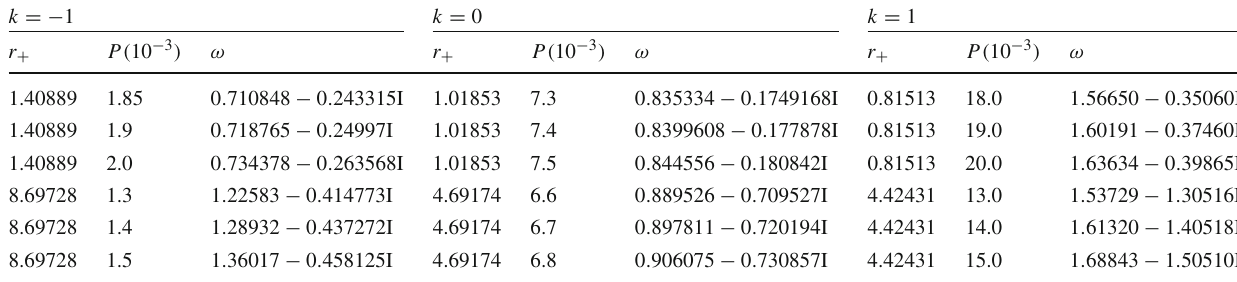
Table 4 The QNM frequencies change as the pressure P